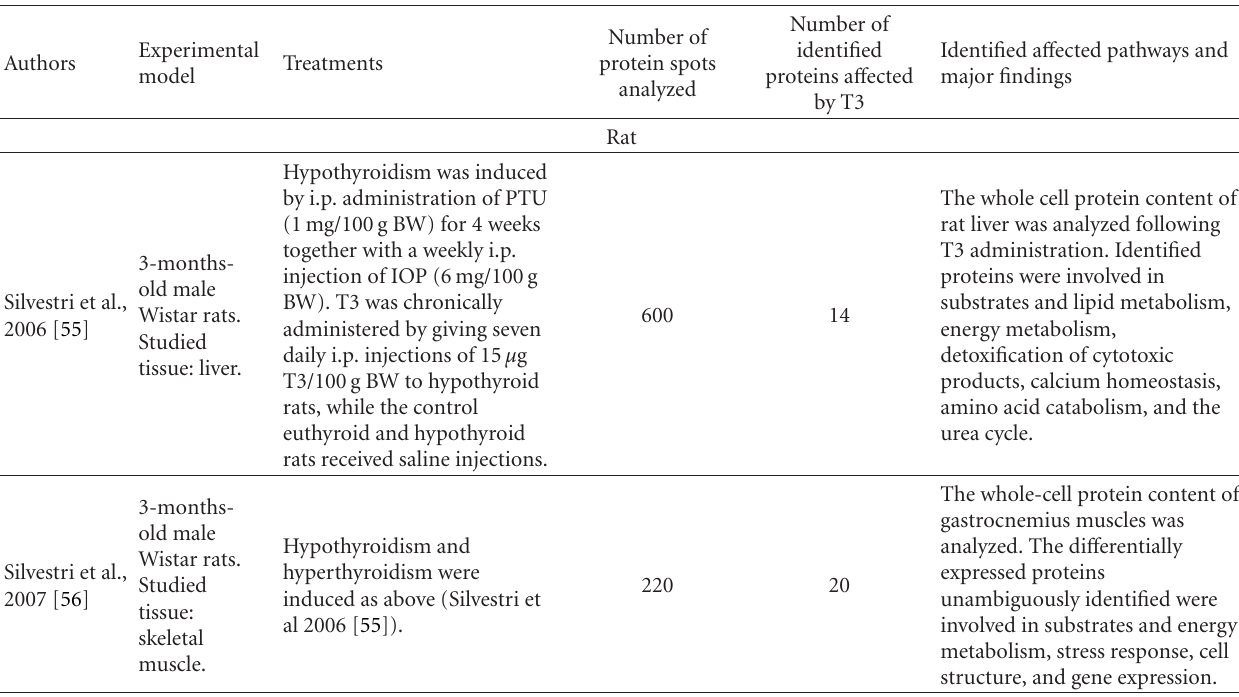
Table 4: Summary of the models used and of the major findings obtained by applying 2D-E and MS to the study of THs e ff ects.